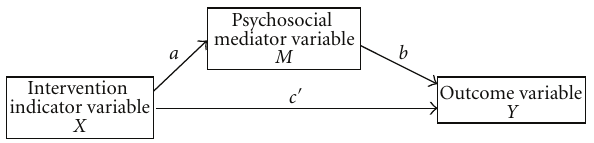
Figure 1: Single mediator